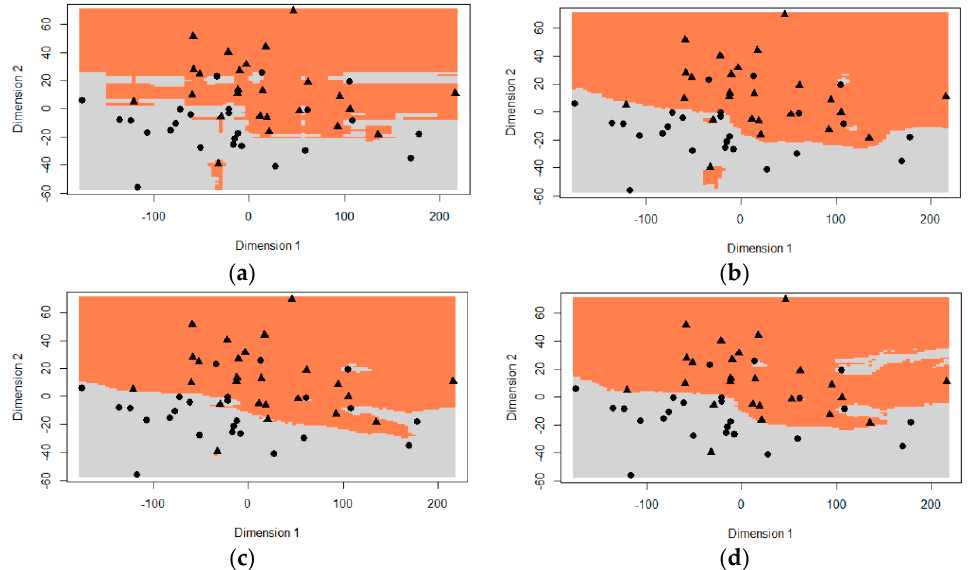
Figure 3. Visualization of the decision boundary for ( a ) RF; ( b ) oRFridge; ( c ) oRFpls; and ( d ) oRFsvm. The margin between the gray and coral areas represents the decision boundary learned. The dots and triangles represent the two classes, i.e., healthy and infected. RF = random forest; rotF = rotation forest; oRFridge = oblique random forest using ridge regression as splitting model; oRFpls = oblique random forest using PLS as splitting model; oRFsvm = oblique random forest using SVM as splitting model.